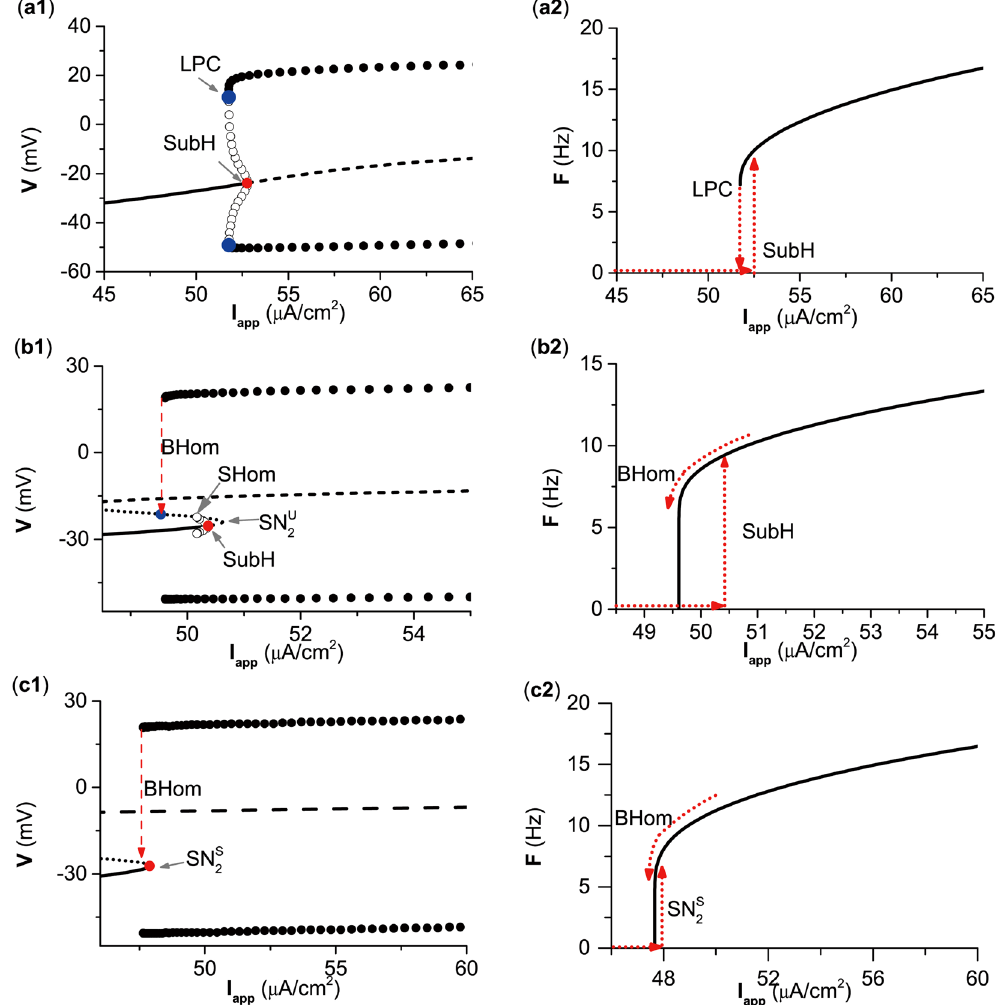
Figure 6. Dynamics of the ML model with respect to I app at different g exc values. ( a ) g exc = 0.0 μ S/cm 2 ; ( b ) g exc = 0.5 μ S/cm 2 ; ( c ) g exc = 2.0 μ S/cm 2 . Left: bifurcation diagrams of V ; Right: firing frequency-current curve. In panels (a1–c1), the solid, dotted and dashed lines represent stable equilibrium, saddle and unstable equilibrium, respectively. The upper and lower solid (open) circles are the maximum and minimum values of the stable (unstable) limit cycle, respectively. BHom and SHom represent saddle homoclinic orbit bifurcation. SN 2S represents saddle node bifurcation of equilibrium. LPC represents saddle node bifurcation of limit